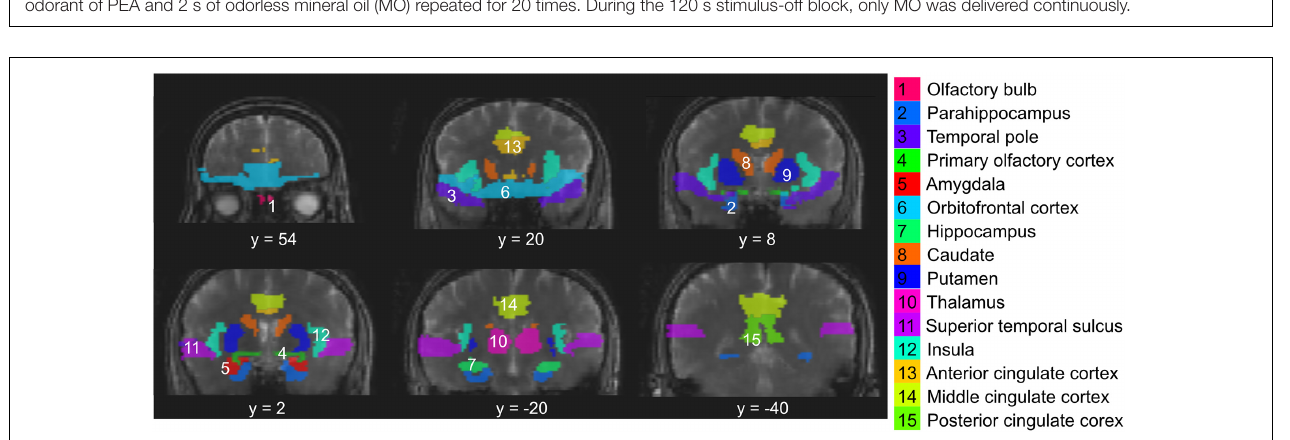
FIGURE 2 | Regions-of-interest (ROI) evaluated in the study overlaid on T2prep BOLD fMRI images from one subject. These include the olfactory bulb (#1), primary olfactory cortex (#4, piriform cortex), and other secondary olfactory regions known from the literature. Note that only six coronal slices were provided to illustrate the locations of the ROIs, but many ROIs can cover more slices. Most olfactory regions are best viewed in the coronal